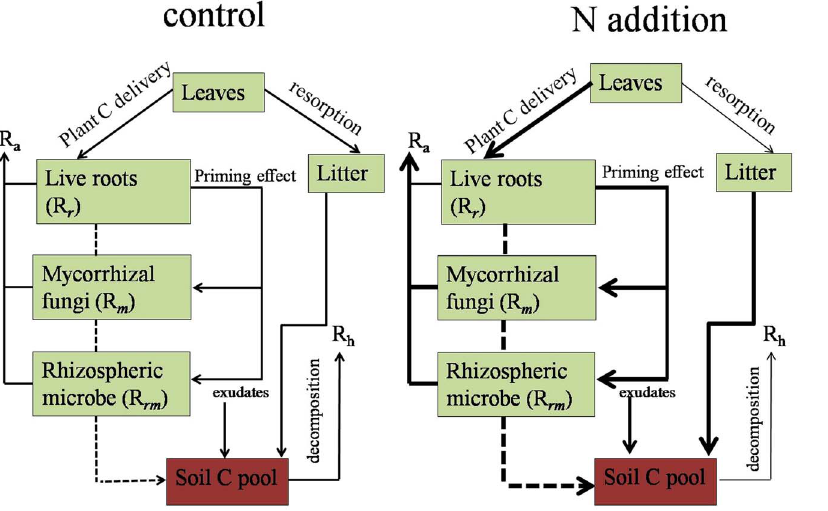
Figure 7. Carbon sequestration and its response to nitrogen (N) addition in plantations. R a and R h are autotrophic and heterotrophic respiration, respectively; R r is live root respiration, R m is respiration of mycorrhizal fungi, and R rm is rhizospheric microbial respiration. Thick arrows represent the enhanced process and thin arrows represent the declined progress in the N addition treatment compared with the control.